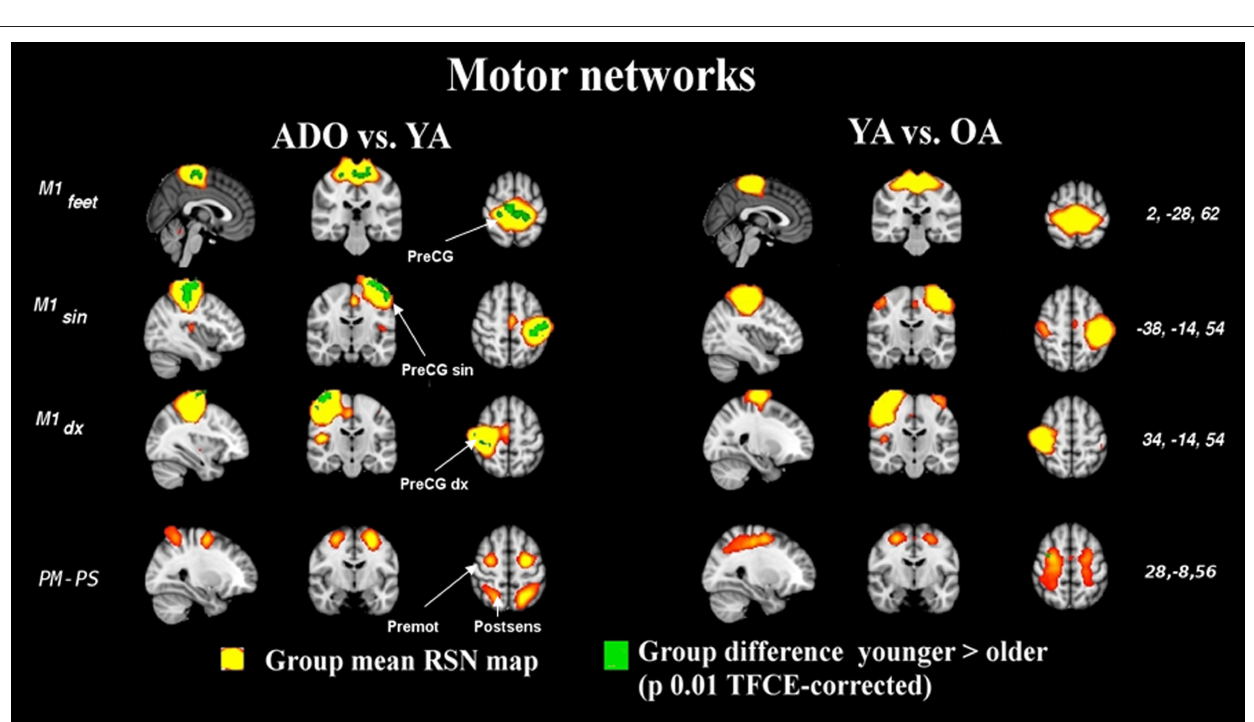
Figure 3 | Mean power spectra of the DMN, salience and executive signal sources in each group. Older adults (OA, blue triangles) have less power in all their signal sources compared to younger adults (YA, red circle) and to adolescents (ADO, black box). Significant differences between the groups are marked with symbols   above the spectra.